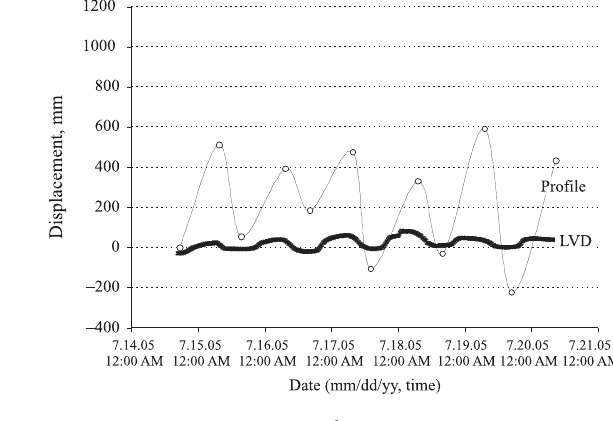
a Fig. 9. Th e comparison of relative displacement of the corner ( R ) with time between LVDT measurement and slab curvature profi le: c a – diagonal direction; b – transverse direction